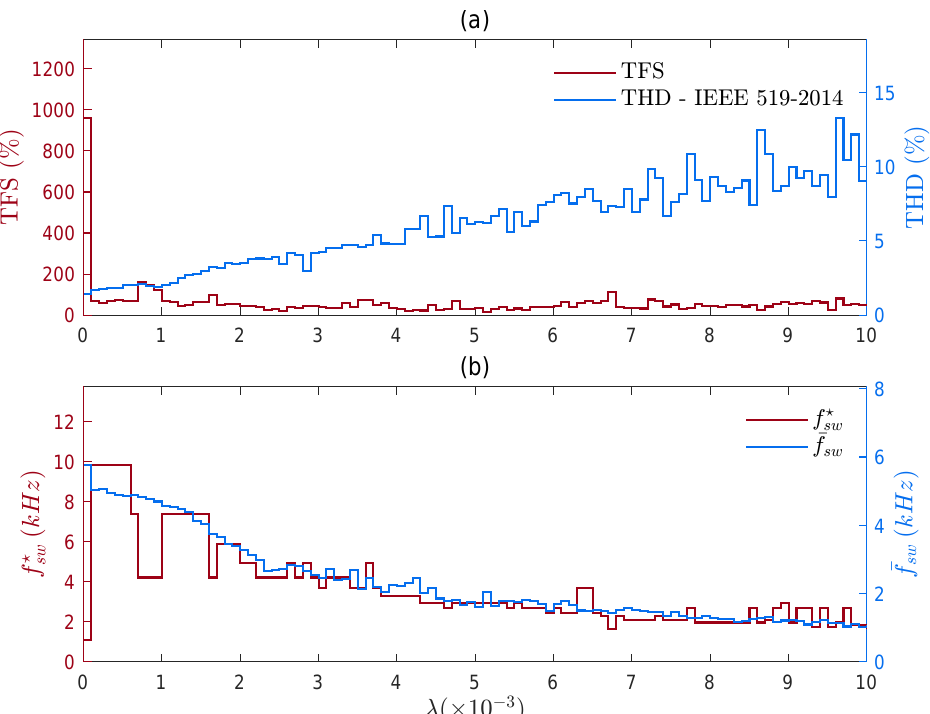
Figure 9. Effect of λ using FCS-MPC with the cost function (12) and sampling period equal to 29,460 Hz ( F s = 491 × 60 Hz): ( a ) TFS and THD; ( b ) f (cid:63) sw and ¯ f sw